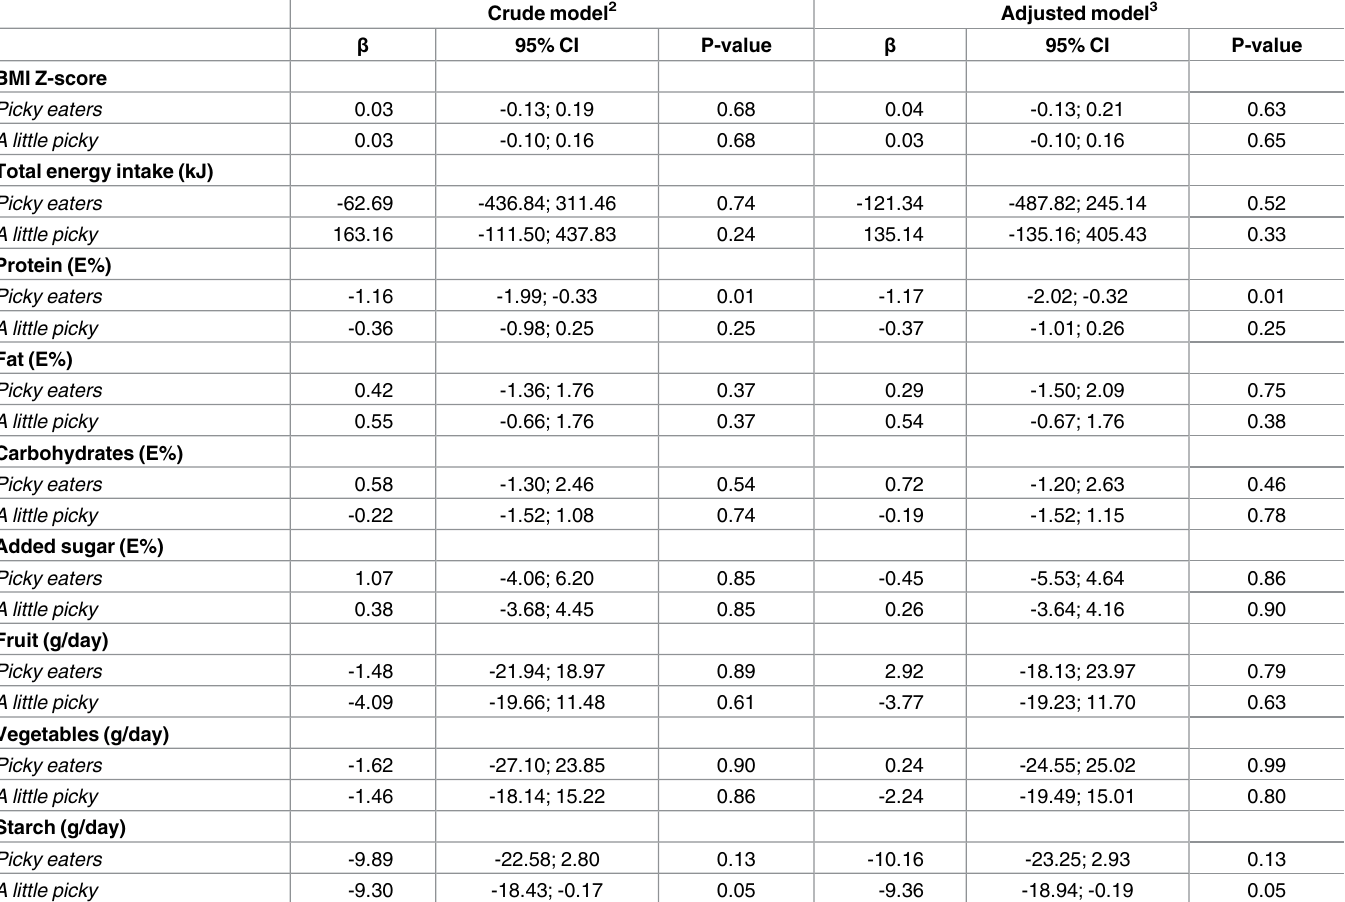
Table 2. Influence of pickiness on BMI z-score, total energy intake, macronutrients and fruit, vegetables and starch intake after 15 month follow up (n = 271) 1